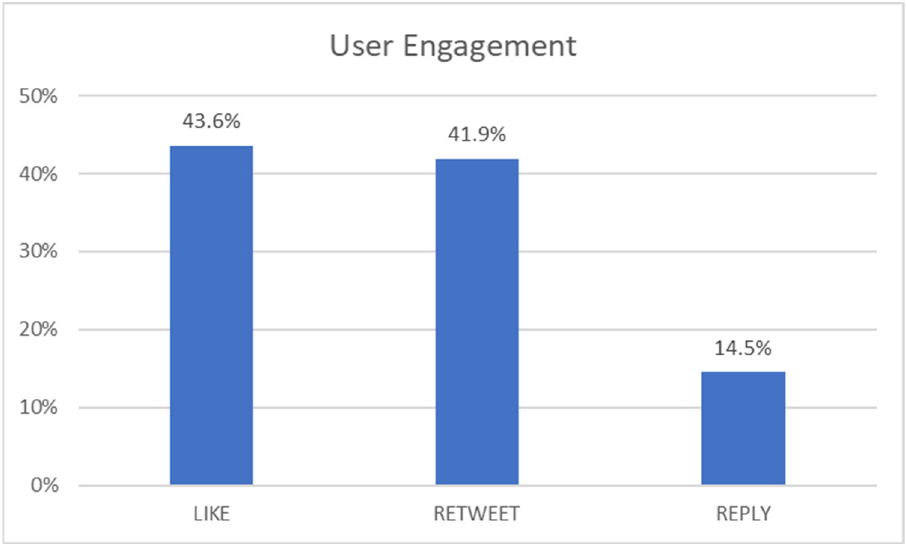
Figure 3. User engagement in tweets (%).